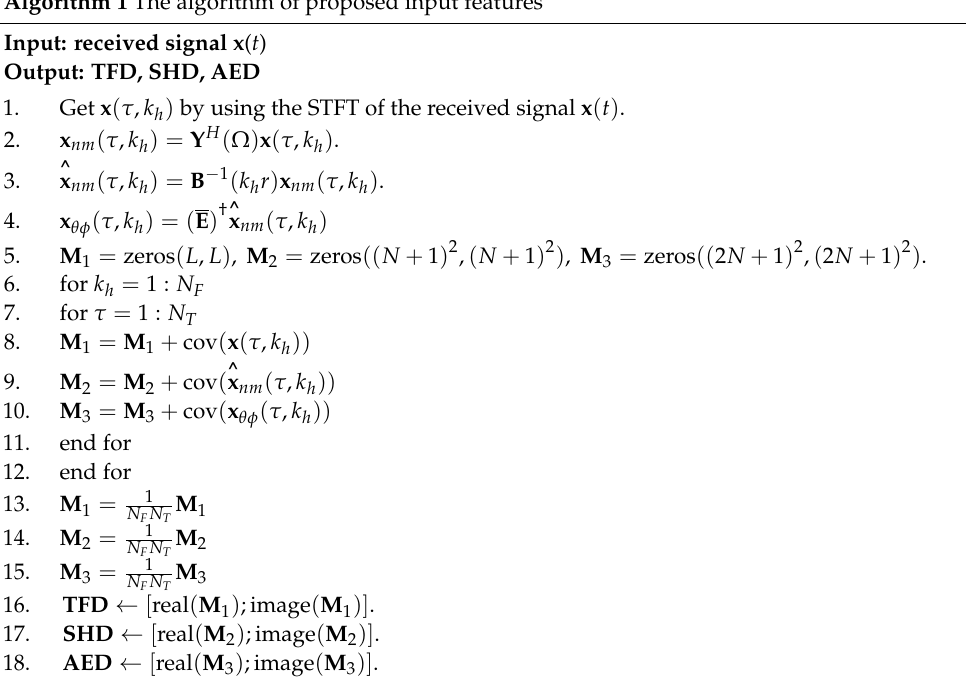
Figure 2. The flowing chart of obtaining the input features. Cov represents the operation to acquire the covariance matrix of the signal. Algorithm 1. The algorithm of proposed input features.